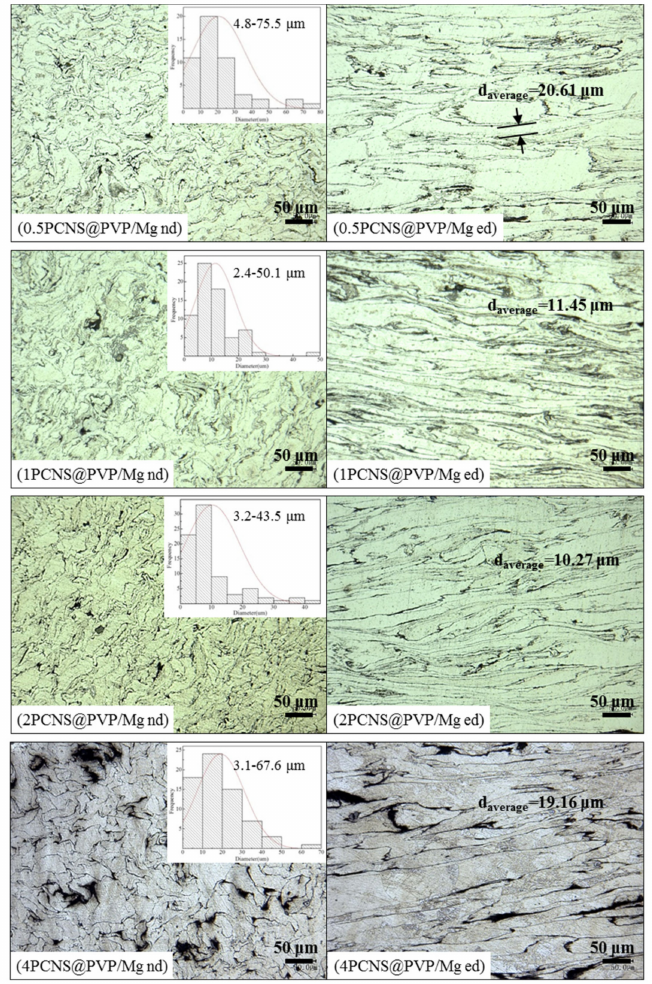
Figure 6. Optical micrographs of xPCNS@PVP / Mg bulk composites with the content of PCNS were 0.5, 1, 2 and 4 wt.%. The left and right images are the microstructure of composites with vertical (nd) and parallel (ed) to the extruded